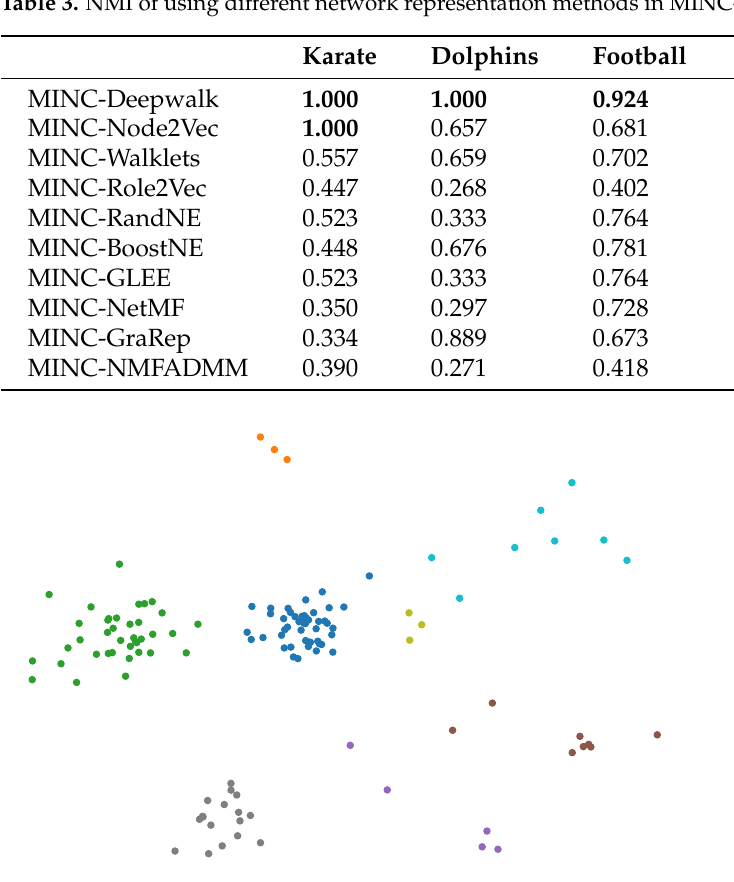
Table 3. NMI of using different network representation methods in MINC-NRL